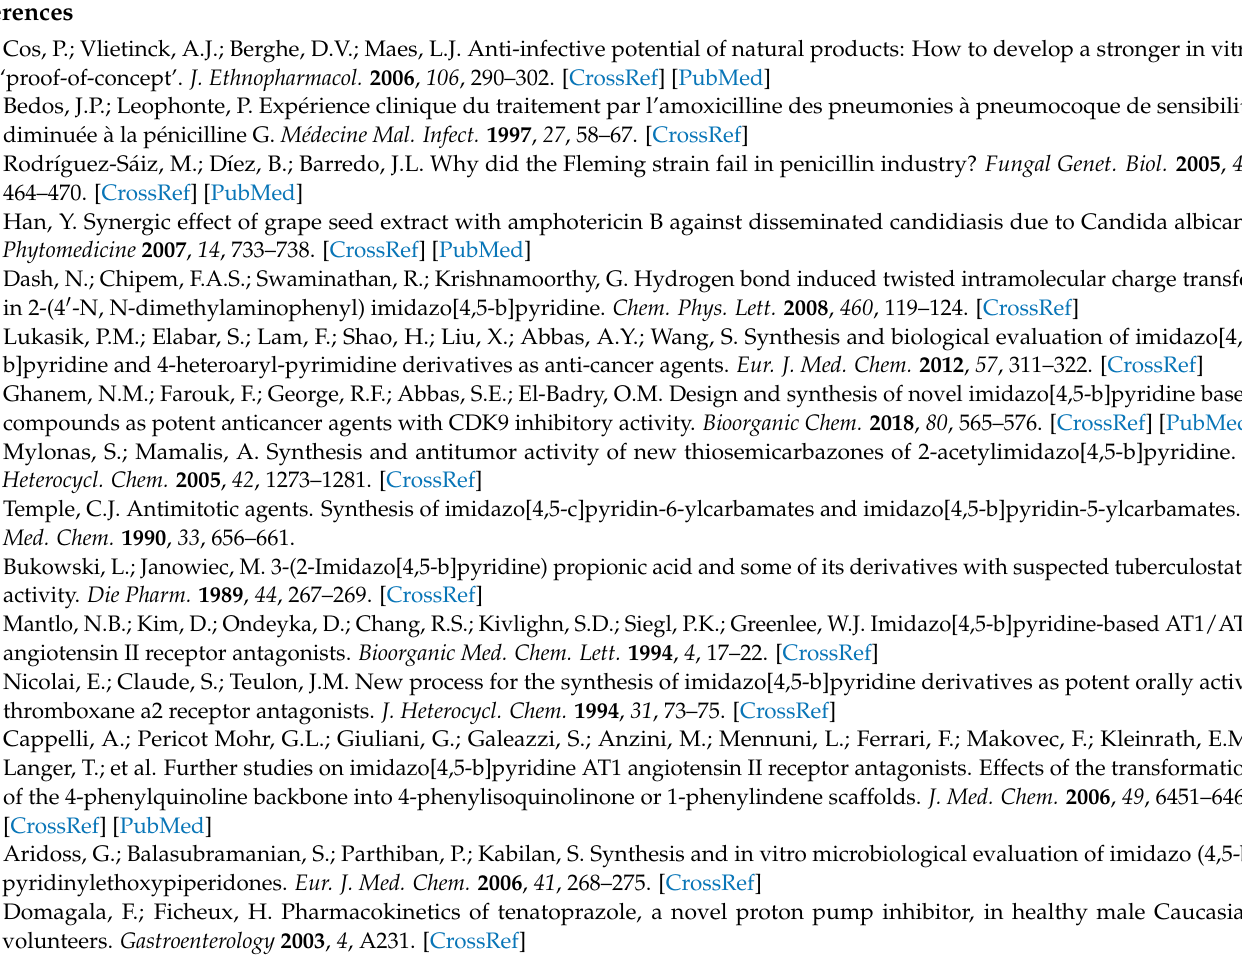
NMR spectrum of 6 ; Figure S3: 13C NMR spectrum of 6 ; Figure S4: 1H NMR spectrum of 7 ; Figure S5: 1H NMR spectrum of 8 ; Figure S6: 13C NMR spectrum of 8 ; Figure S7: Oretp view of 3 , 6 and 8 ; Table S1. Sample, Data collection and structure refinement crystal data for 3 ; Table S2. Sample, Data collection and structure refinement crystal data for 6 ; Table S3. Sample, crystal data, data collection and structure refinement for 8 ; Table S4: the H-bond geometry (Å, ◦ ) in 3 , 6 and 8